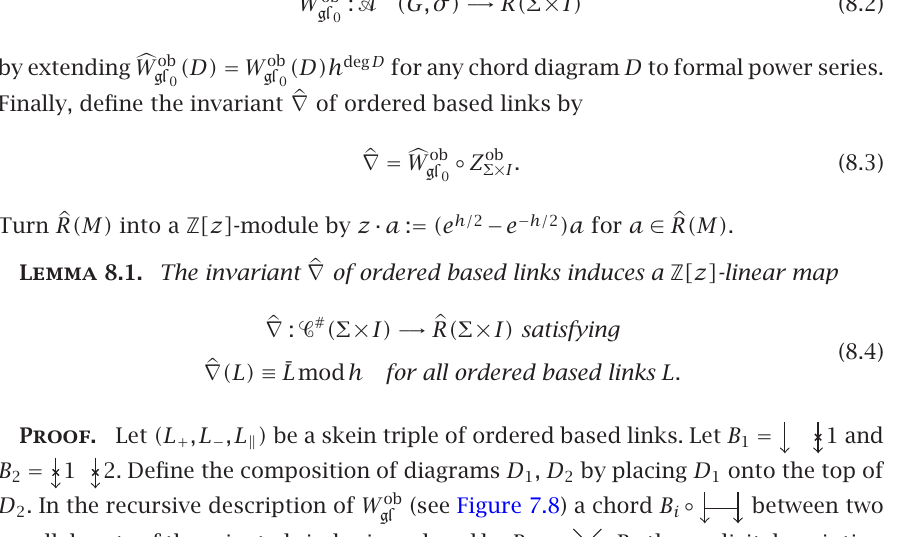
and W ob by local replacement gl gl 0